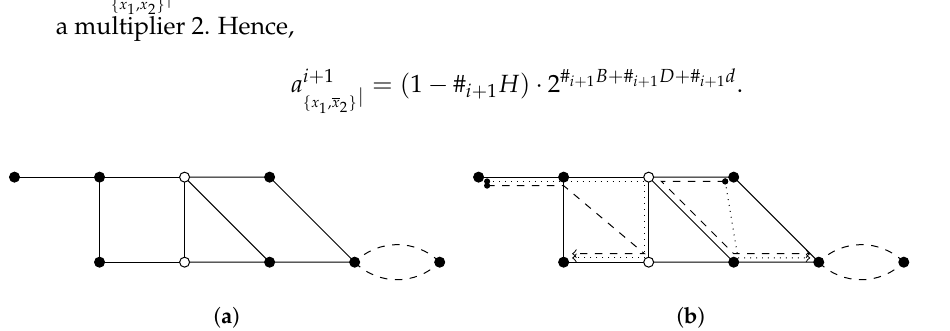
(cid:108) (cid:108) T , where sig ( T i ) Fr = L . White vertices are right wall vertices of tile i + 1